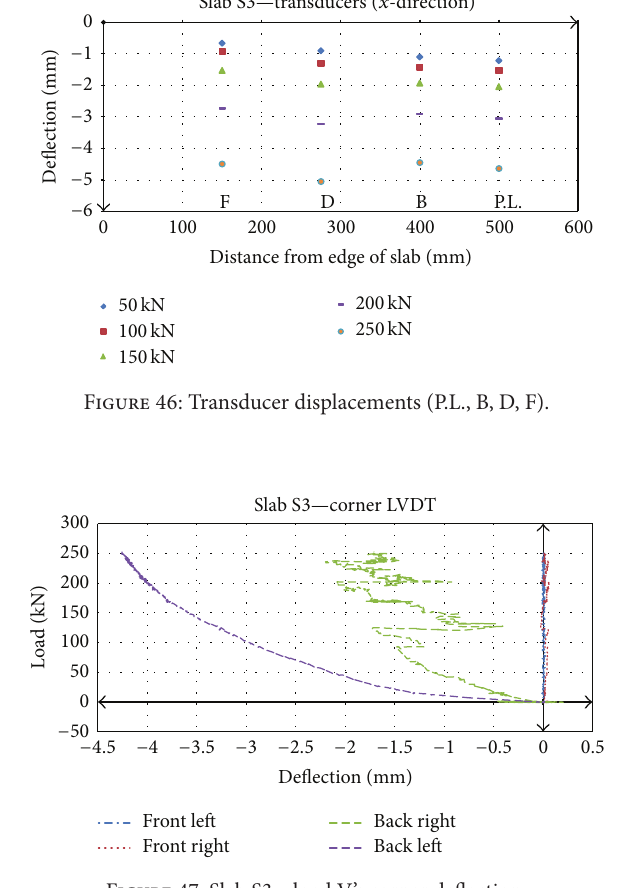
Figure 47: Slab S3—load V’s corner deflection.